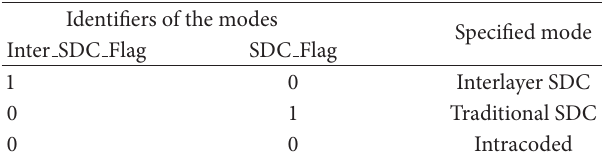
Figure 3: Percentages of SDC-coded block in 300 I-frames. Table 1: Identifiers on interlayer SDC and traditional